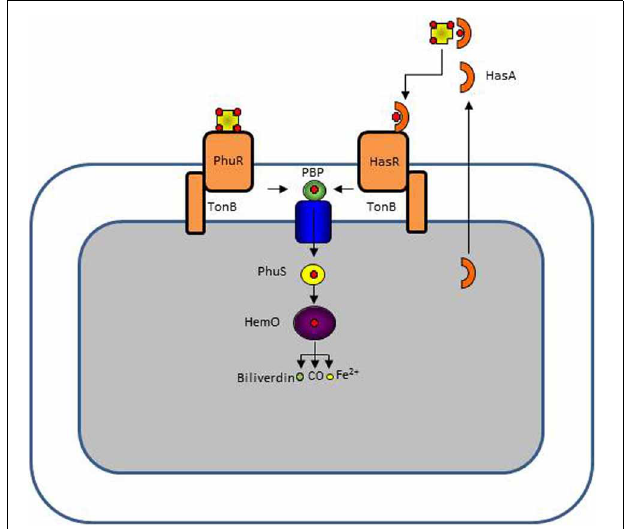
FIGURE 3 | P. aeruginosa has two heme uptake systems, Phu, and Has. The PhuR TonB-dependent receptor binds directly hemoproteins extracting heme while the HasR receptor binds heme complexed to a secreted hemophore protein HasA. In the periplasm heme is bound to a periplasmic protein which delivers it to an ABC transporter. In the cytoplasm heme is directed to the heme oxygenase HemO by the PhuS chaperone. HemO cleaves the tetrapyrrole ring, leaving biliverdin, CO, and Fe 2 + .